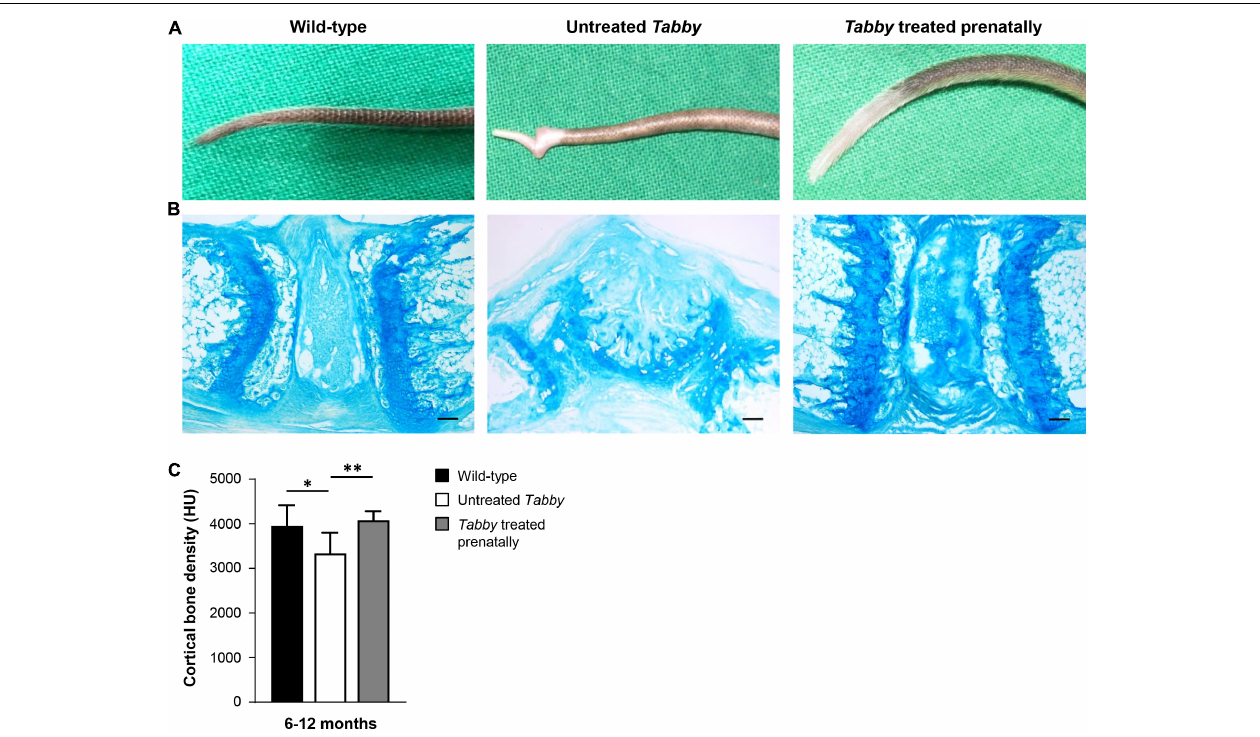
FIGURE 6 | EDA1 replacement in utero corrects vertebral bone development in Tabby mice. (A) Representative tails of wild-type, untreated, and prenatally treated Tabby mice. (B) Tail tip sections from the region of the kink stained with alcian blue (scale bar: 100 µ m). (C) Vertebral bone density (Hounsfield units) of wild-type mice ( n = 6; black bar), untreated Tabby mice ( n = 6; white bar) and Tabby mice treated in utero ( n = 7; gray bar). All animals were 6–12 months old. Data are shown as mean ± SD; ∗ p < 0.05; ∗∗ p =